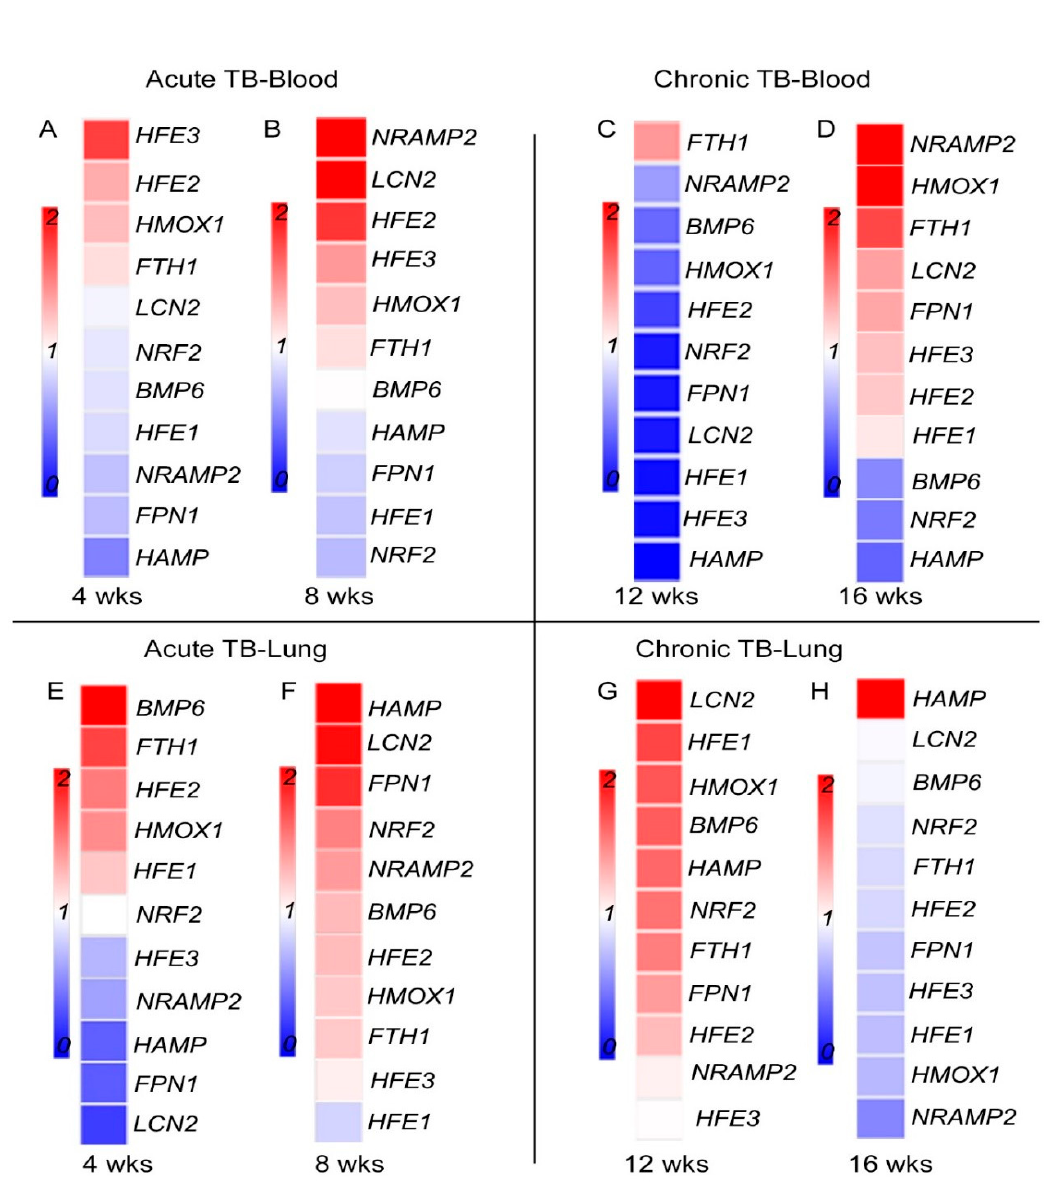
Figure 4. E ff ect of Fe-supplementation on the expression of host iron-responsive genes in Mtb-infected rabbits. Heat map of selected immune response gene expression in the blood ( A – D ) or lung ( E – H ) during acute (4 and 8 weeks; A , B , E , F ) or chronic (12 and 16 weeks; C , D , G , H ) stages of infection in rabbits treated with Fe. The data from Fe-supplemented animals was calibrated with the corresponding levels in placebo-treated animals. Host house-keeping gene ( GAPDH) expression was used to normalize target gene expression. Red color indicates up-regulation and blue color indicates down-regulation. The gradient in color indicates the trend towards up- or down-regulation.